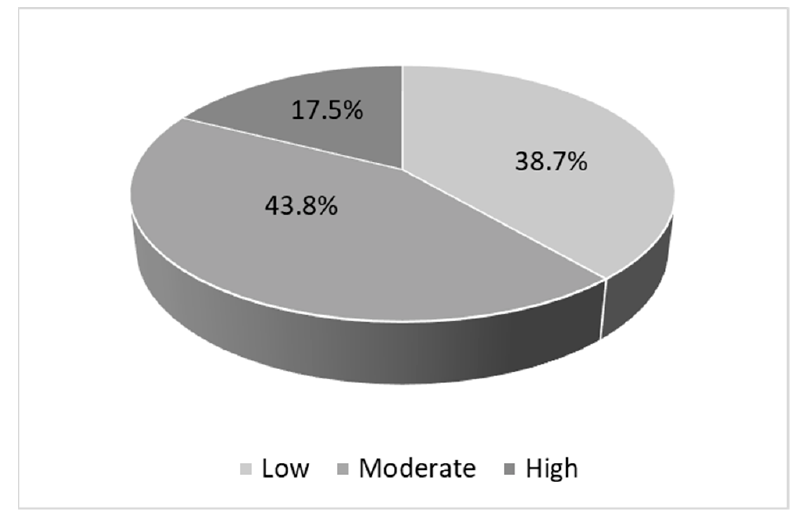
Figure 1. Level of concern of contagion of COVID-19. Table 2. Answers to the questions related to the Scale of Concern of Contagion of